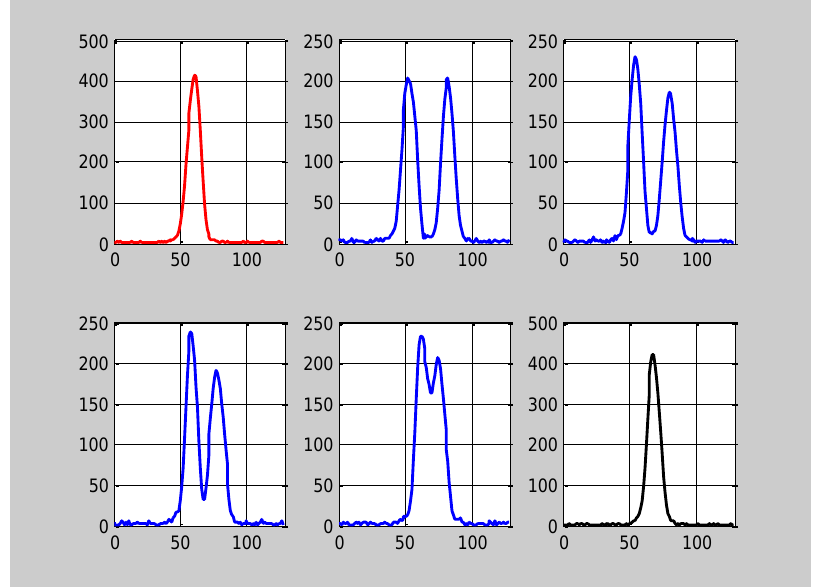
Figure 3. Dependence of 1D imaging profile for 2 capillary tubes with doped (paramagnetic Mn 2+ ) water on the position of the sample in the bore of magnet. The direction of X-(Y-) gradient was fixed. The data for 6 positions of the sample after the rotation around B 0 are presented. When X-(Y-) gradient was orthogonal to the flat of the capillaries, maximal distance between two peaks of equal intensity has been observed in imaging profile. When the direction of the gradient was in the flat of two capillaries, the only one peak has been registered. 400 MHz. T =298 K. The intensity (Y-axis) scale is in arbitrary units. X-axis scale is in points.